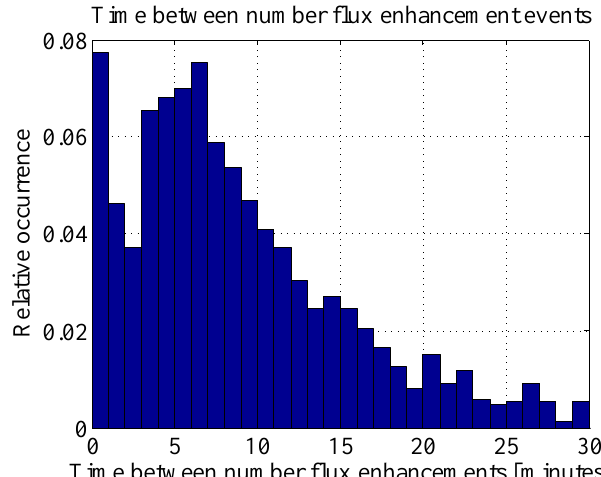
Fig. 4. Superposed epoch analysis of enhanced number flux events. For each event the values have been normalized to the range 0 to 1 by dividing with the maximum value in the superposed epoch win- dow of ± 2min. The x-axis shows the time relative to the enhanced number flux events [minutes]. The y-axis shows the normalized value of the following parameters: Black: Density, Blue: paral- lel velocity, Green: number flux, Red: perpendicular temperature, Cyan: magnitude of perpendicular velocity and Magenta: magni- tude of vector change of perpendicular